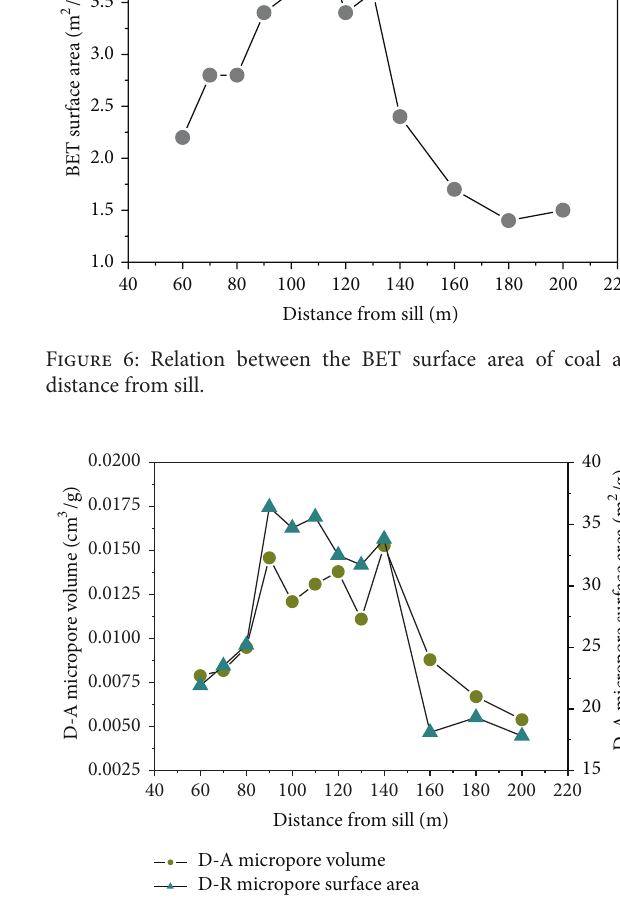
Figure 7: Evolution of micropore volume and surface area with decreasing distance from